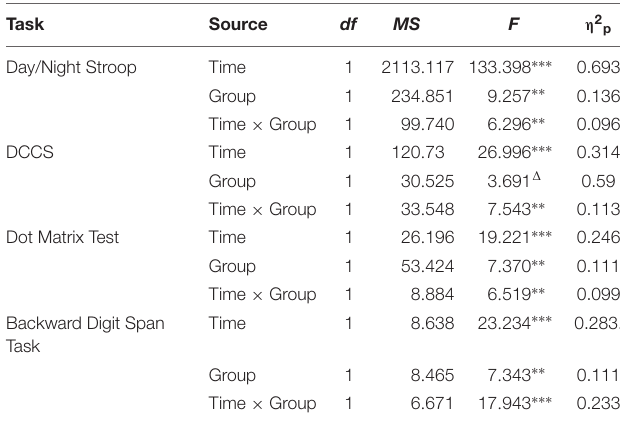
TABLE 6 | Analysis of variance analysis before and after music